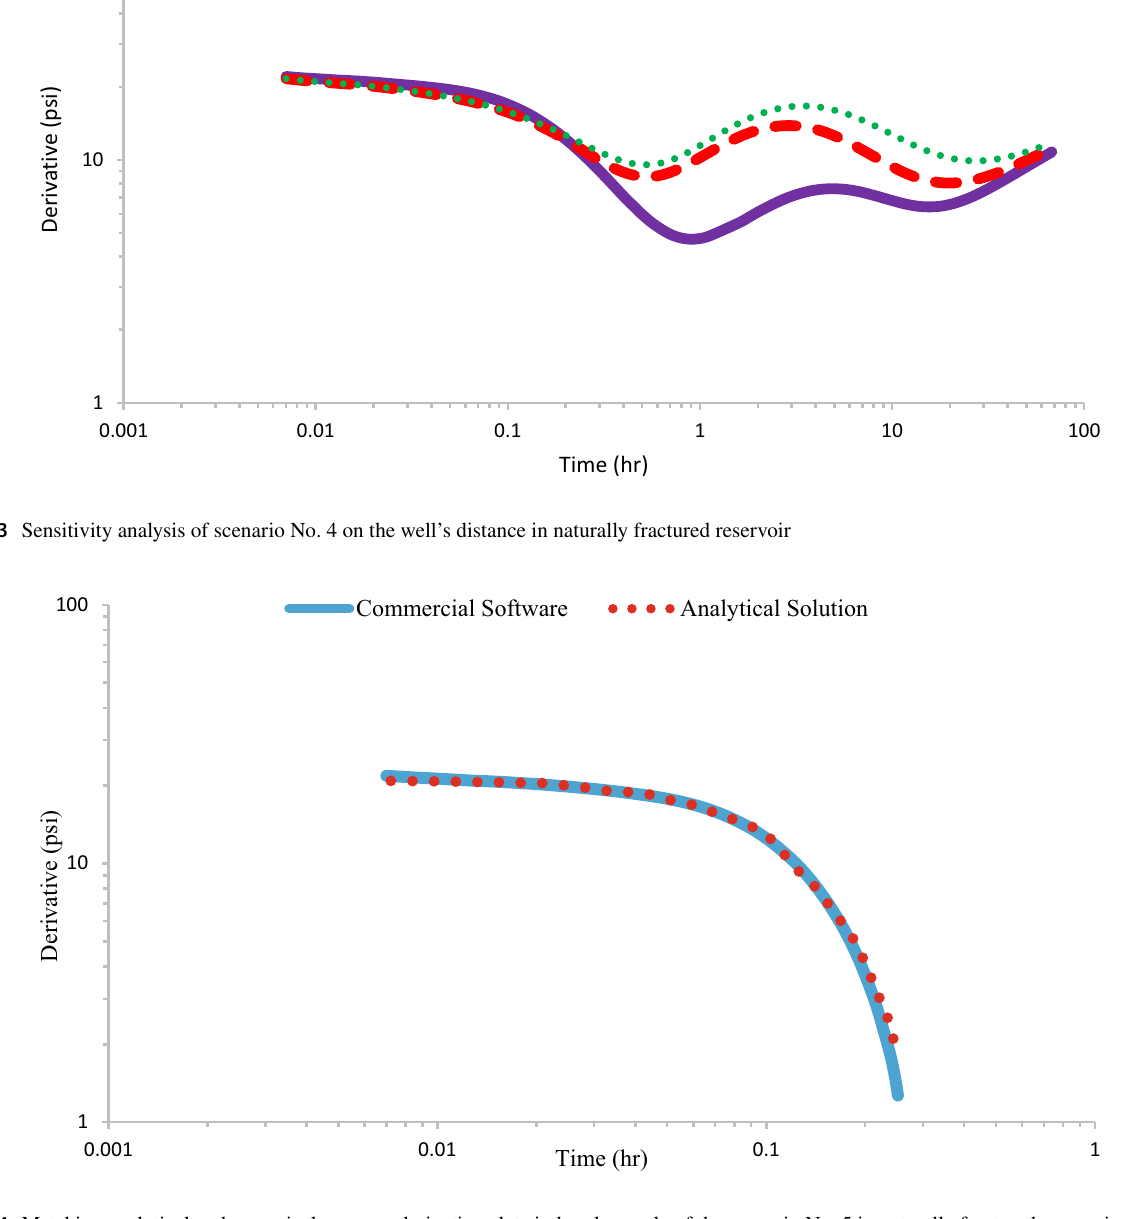
Fig. 14 Matching analytical and numerical pressure derivative plots in log–log scale of the scenario No. 5 in naturally fractured